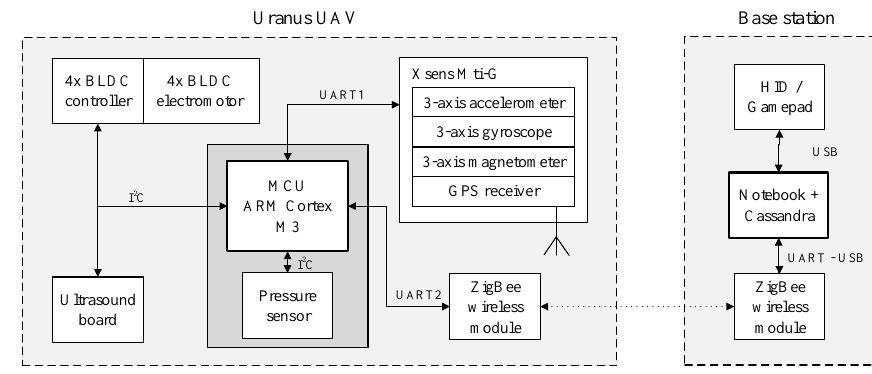
Figure 5. The block scheme of Uranus UAV system.